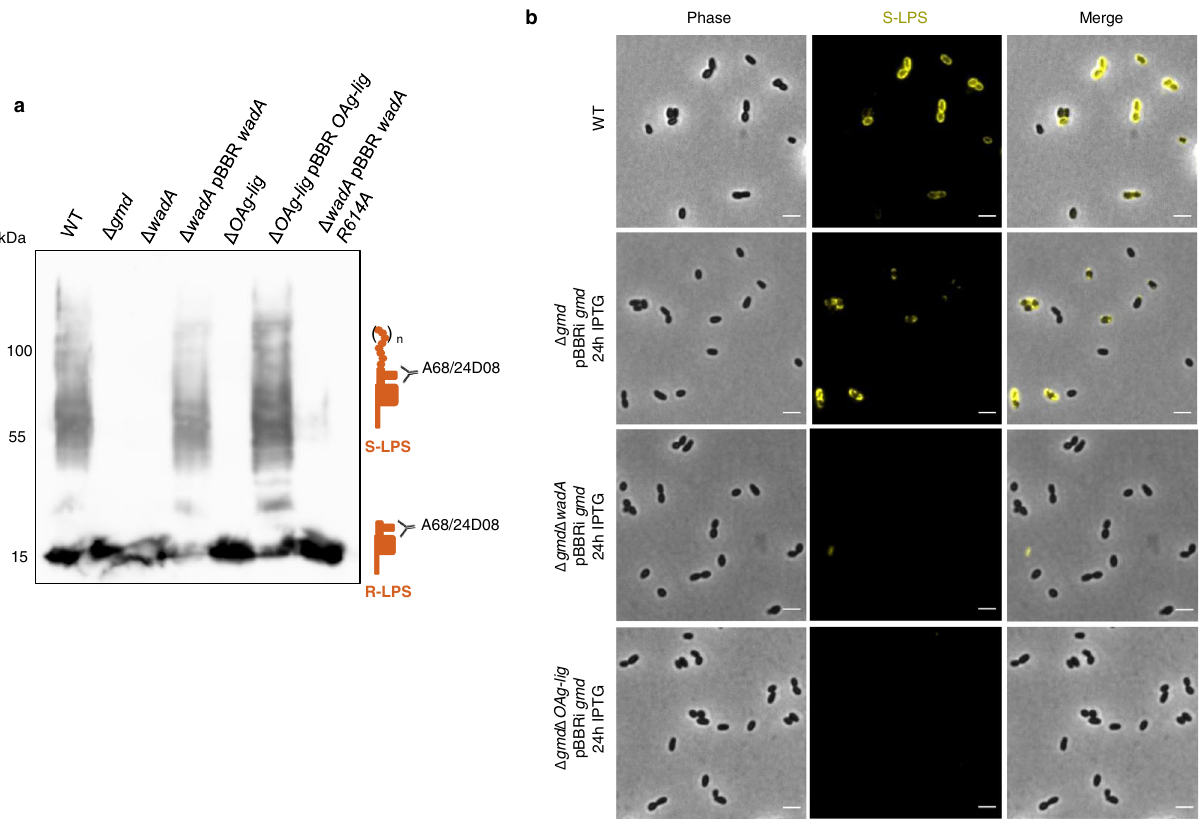
Fig.7|WadAisthemainO-antigenligasein Brucella spp.a WBanalysisusingan antibodyagainstthecoreoftheLPS(A68/24D08)in B.melitensis 16Mmutants.WB wasperformedinbiologicaltriplicatesgivingsimilarresults( n =3).Sourcedataare provided as a Source Data fi le. b Immuno fl uorescence microscopy labelling the